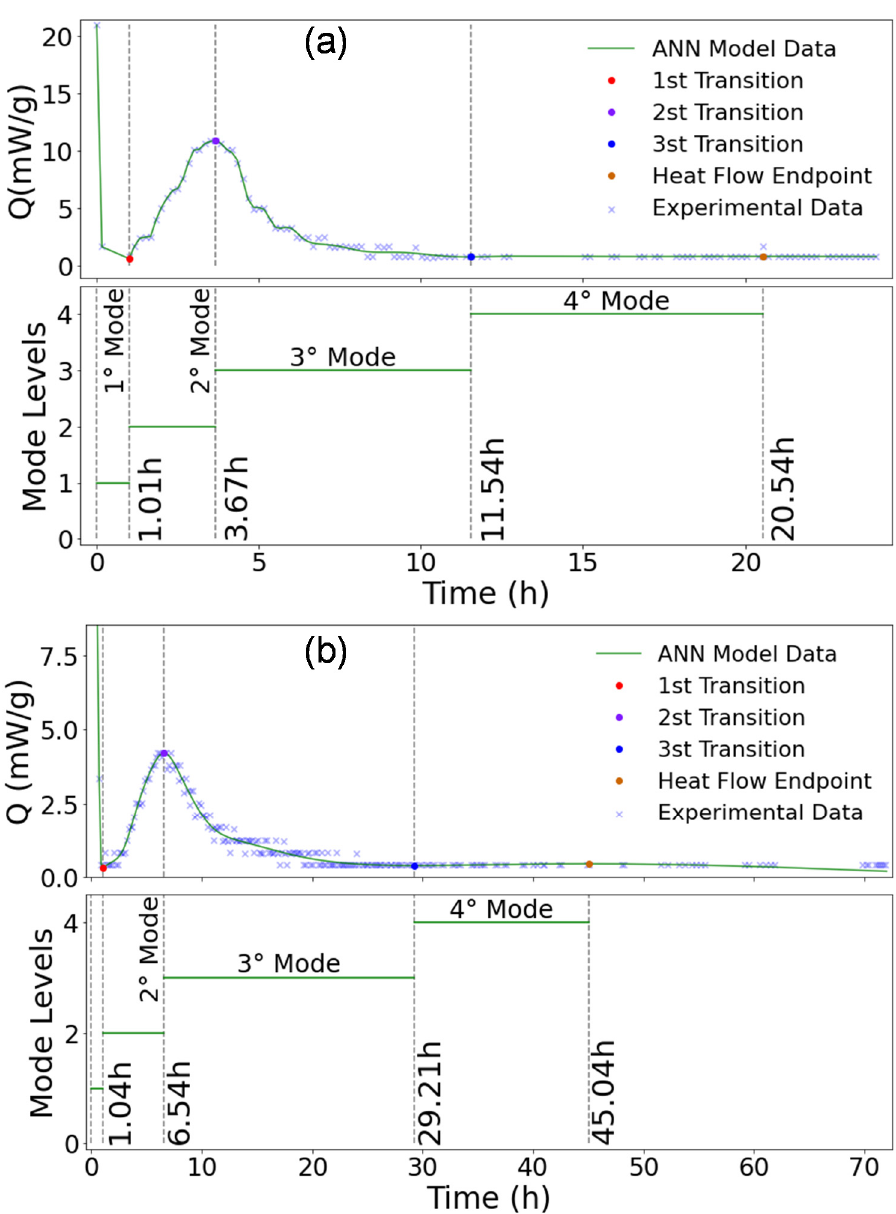
Figure 13. Heat of hydration, ANN model generated, modes, and transitions identification: ( a ) CEM I and ( b ) CEM I + GP.